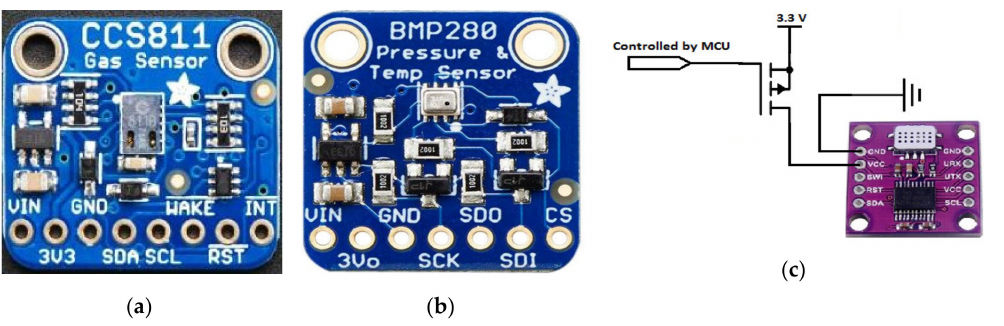
Figure 10. ( a ) CCS811 breakout board for detecting total volatile organic compounds (TVOCs) and eCO 2 concentration; ( b ) BPM280 breakout board used for monitoring environmental temperature and humidity; ( c ) MiCS-5914 breakout board for detecting the ammonia